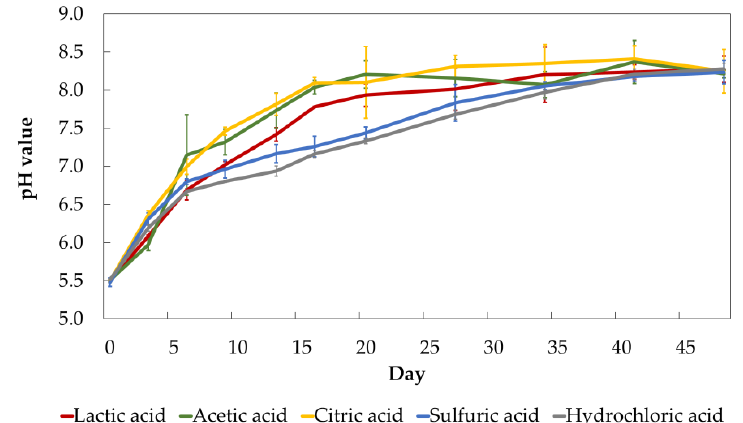
Figure 2. The pH value of dairy cow slurry after acidification with different organic (lactic, acetic, and citric acid) and mineral acids (sulfuric and hydrochloric acid) to a pH value of 5.5 during the storage period of 48 days (means ± SD, n = 3). storage period of 48 days (means ± SD, n = 3).